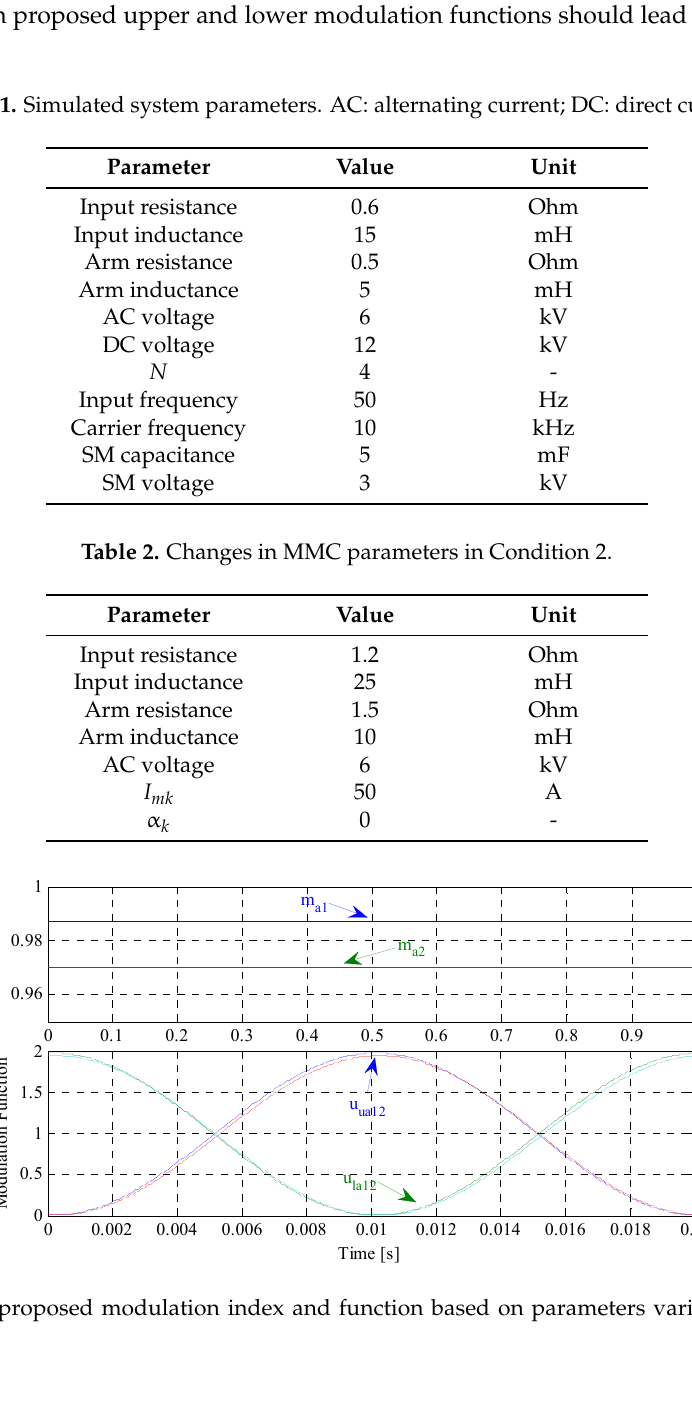
6 of 14 Table 1. Simulated system parameters. AC: alternating current; DC: direct current.